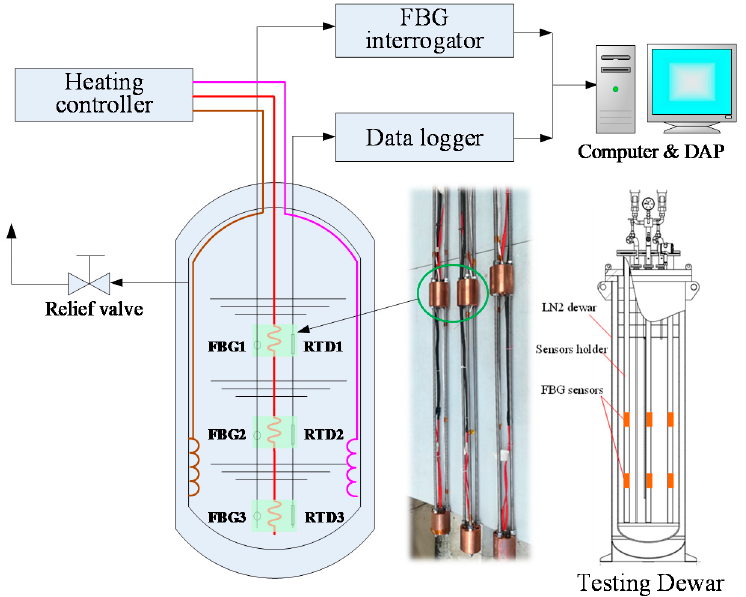
Figure 3. Experiment setup of FBG temperature sensors in testing Dewar.